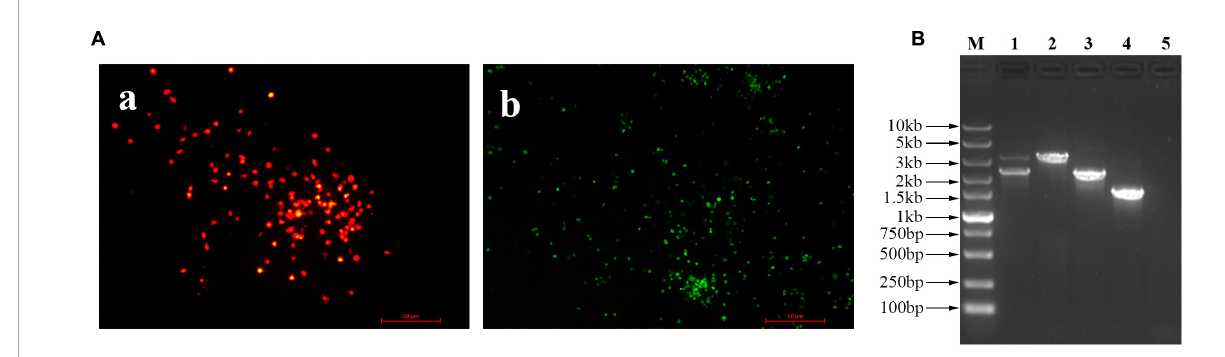
FIGURE2 Generation and purification of the recombinant virus FAdV4-HA(H9). (A) The fluorescent plaques of the rescued recombinant virus FAdV4-HA(H9). At 72 hpi, the viral supernatant was blind passaged into the LMH cells, and the fluorescent plaques were observed with the fluorescent microscopy. (a) Red indicated the recombinant virus FAdV4-HA(H9), (b) green indicated the parental virus FA4-EGFP. (B) PCR analysis of the recombinant virus FAdV4-HA(H9). Lanes 1–5 represent unpurified recombinant virus, purified recombinant virus, parental virus FA4-EGFP, wild-type FAdV-4, and negative control, respectively. These experiments were performed twice with comparable results.